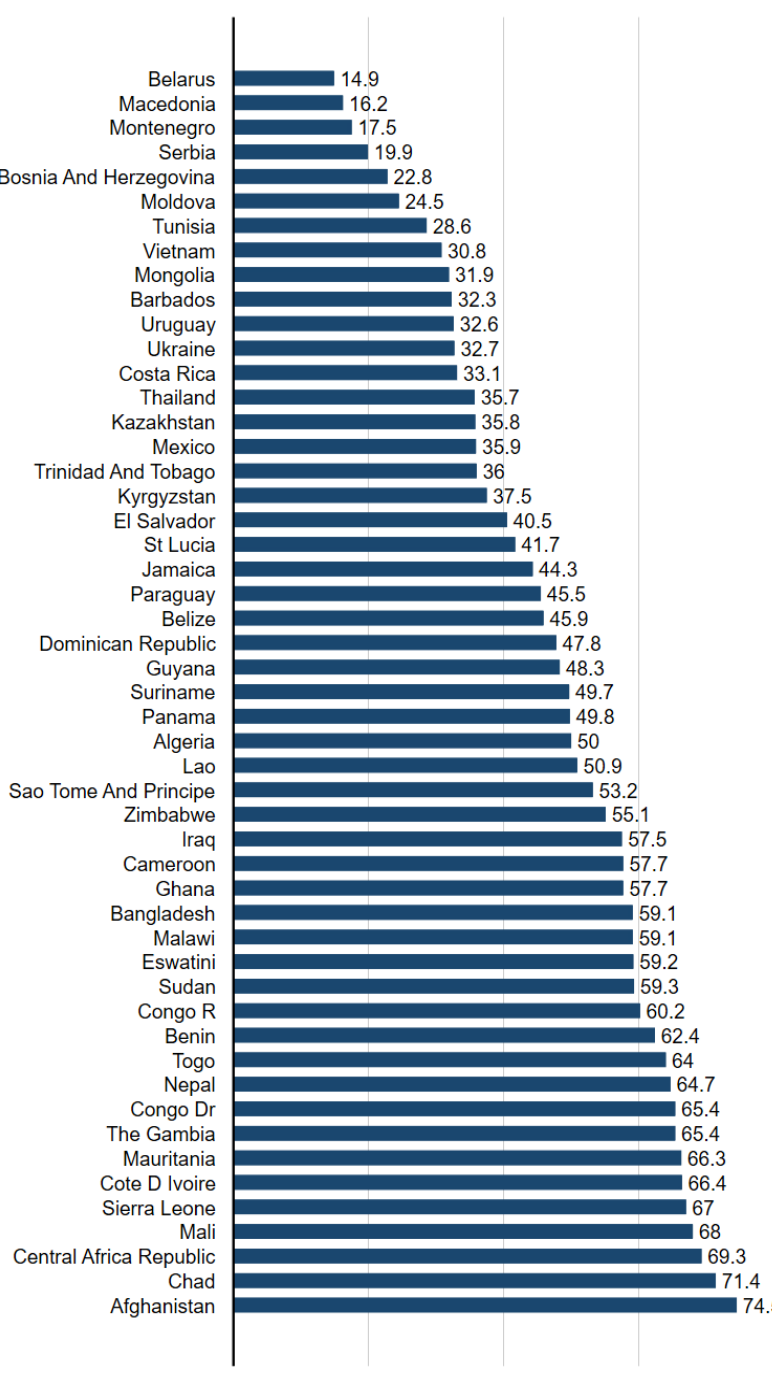
Figure 1. Gender Inequality Index Across 51 Countries in Analysis Sample.